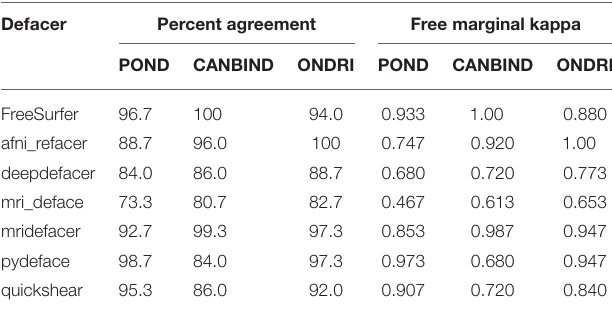
TABLE 5 | Inter-rater reliability for manual ratings of each dataset and algorithm, as measured using percent agreement and free-marginal kappa. Defacer